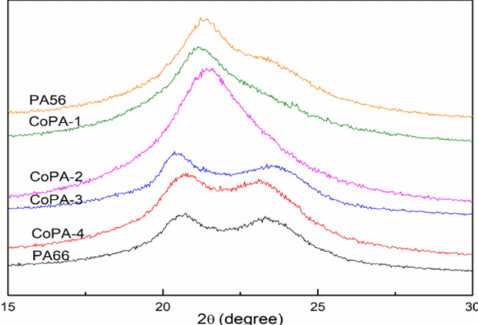
Figure 5. WAXS scans for PA56/66